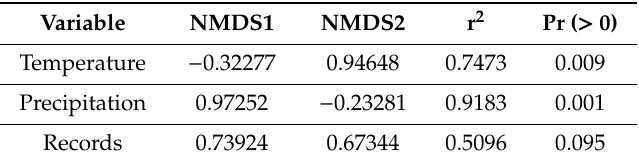
Table 3. NMDS vector fitted values. Temp: Max temperature of warmest month, Precipitation: Annual precipitation, Records: Number of records of geometrid